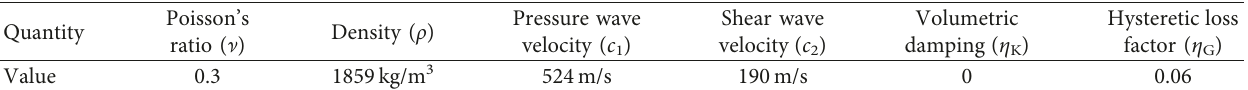
Figure 15: GDS test system. Table 6: The parameter of the soil.